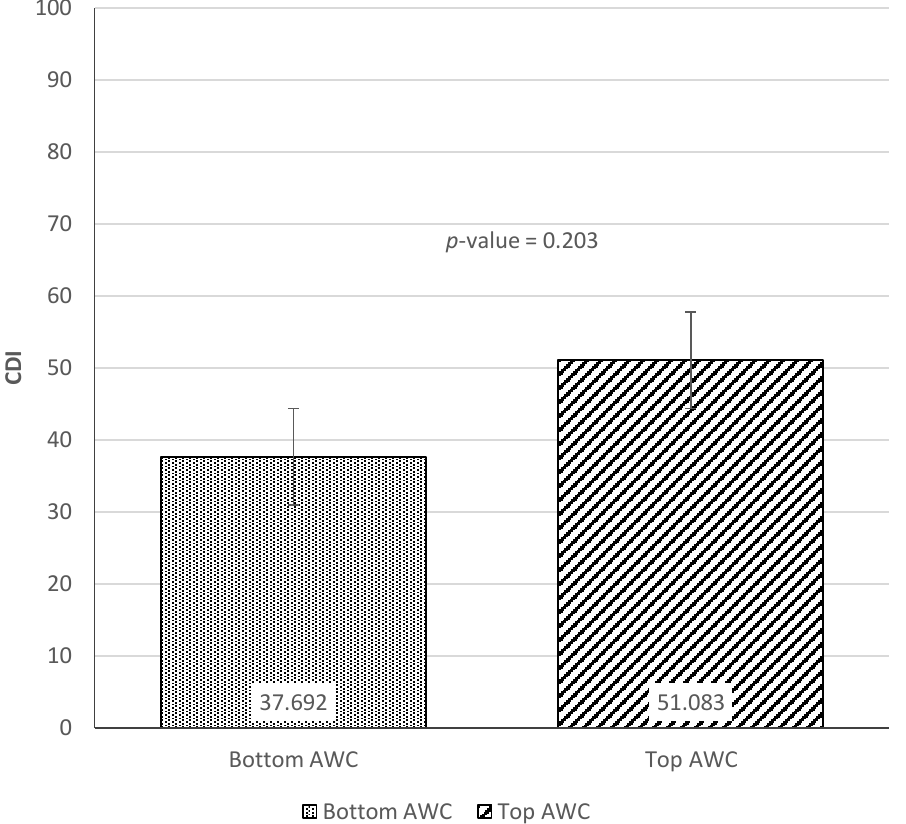
Figure 6. Difference in Communicative Development Inventories scores between top and bottom terciles of Adult Word Count.